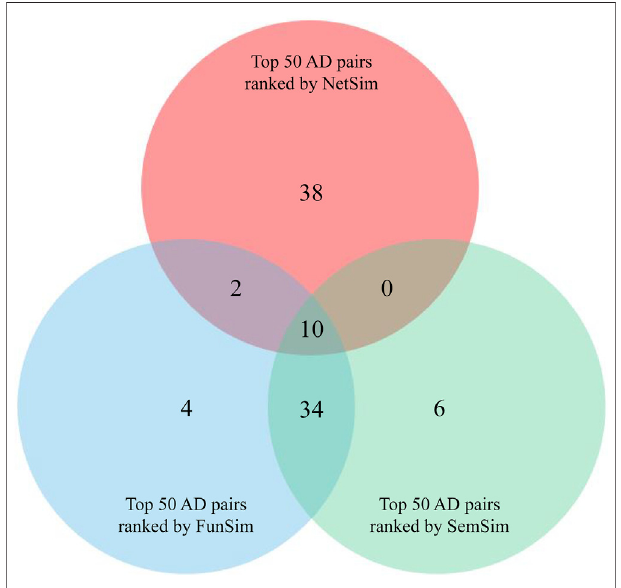
FIGURE2| VenndiagramanalysisofthreegroupsofADpairsrankedby NetSim, FunSim, and SemSim